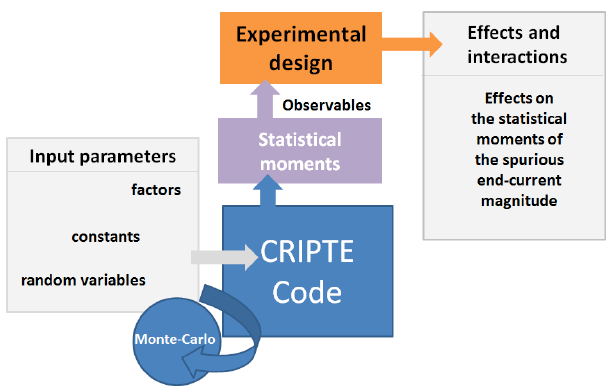
Figure 4: Description of the experimentation process